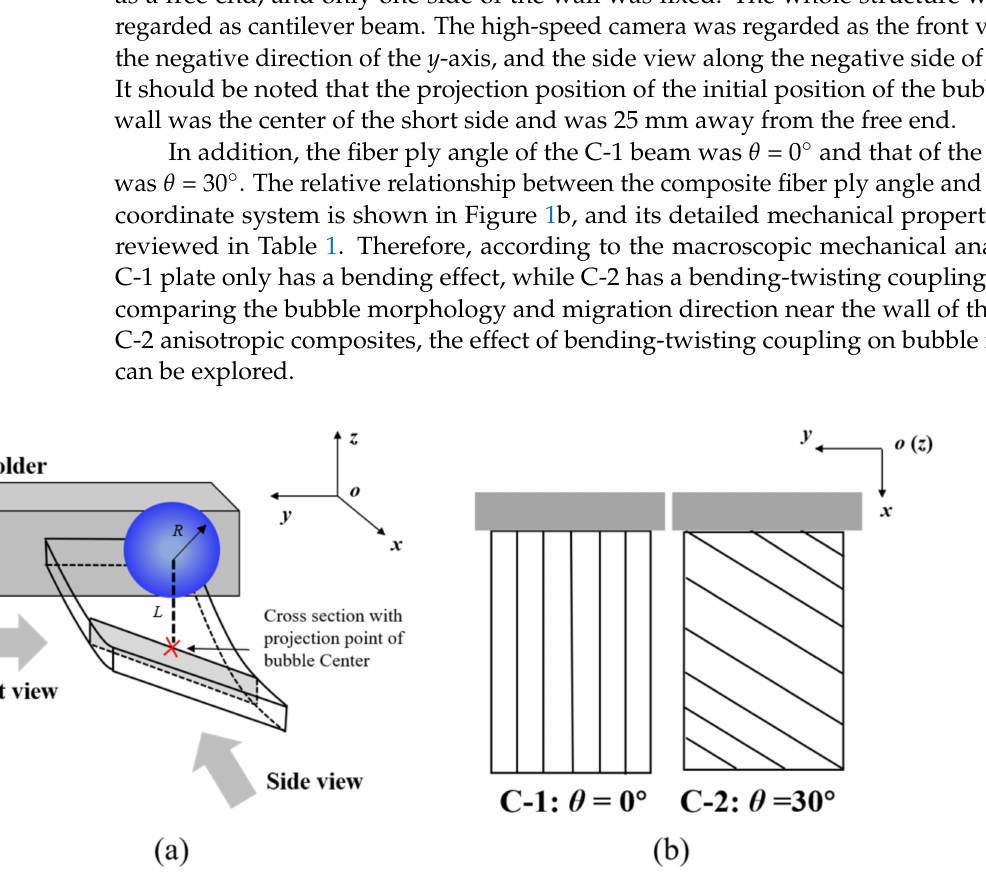
Figure 1. Schematic diagram of ( a ) fixation mode and ( b ) fiber ply angle of anisotropic composite beams. Table 1. Mechanical properties of carbon fiber